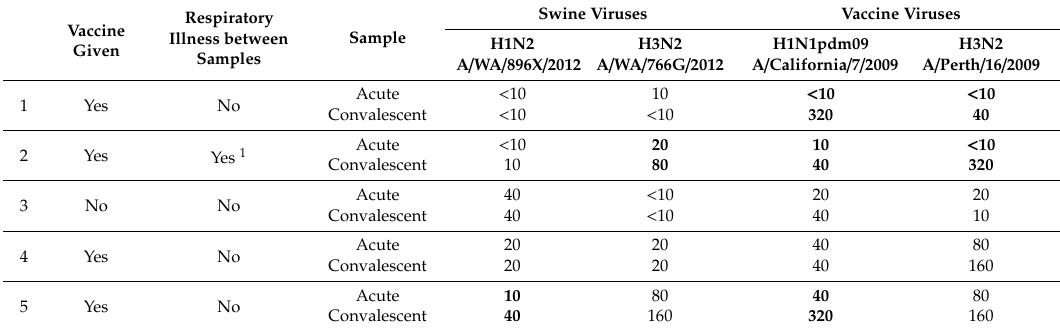
Table 1. Acute and convalescent serum HI titers to swine and vaccine influenza A viruses for five workers with respiratory illness who provided acute and convalescent samples. Significant titer changes are in bolded text. Swine Viruses Vaccine Viruses Respiratory Vaccine Sample Illness between Given Samples